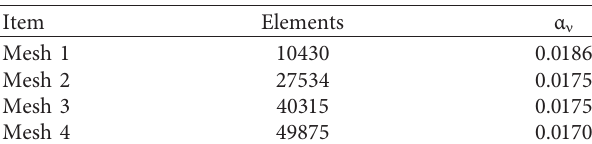
Figure 9: Valve plate triangular throttling groove cavitation simulation model. Table 2: Valve plate triangular throttling mesh independence test ( c � 50 ° and θ � 4 ° ).